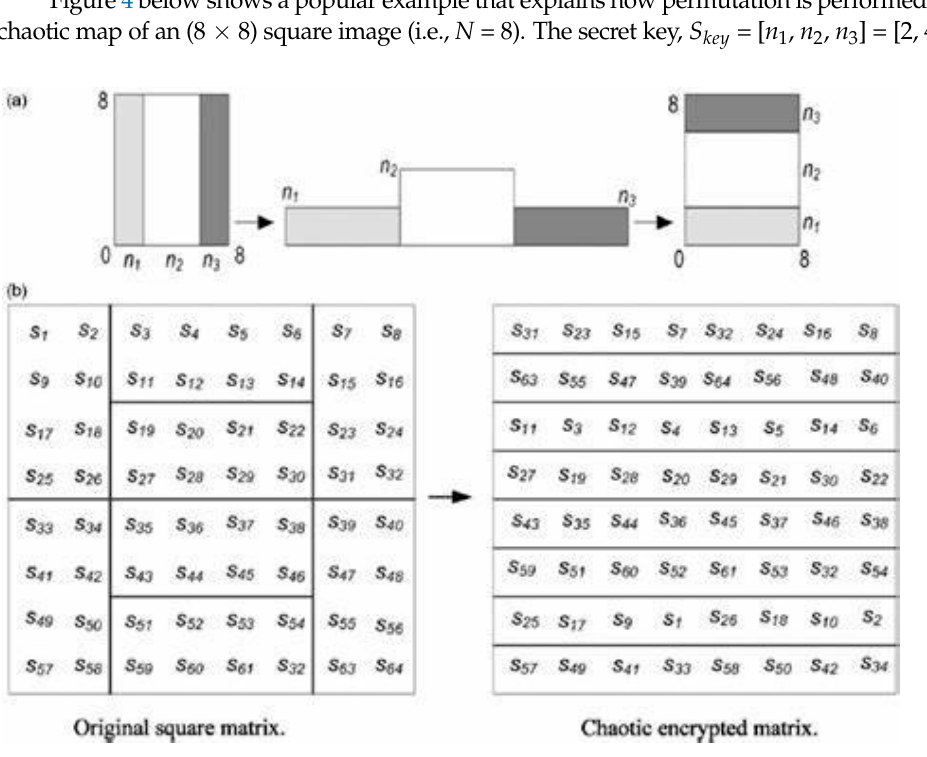
Figure 4. ( a ) The 8 × 8 matrix divided into blocks, and ( b ) represents the matrix after applying the 2D baker map [24].